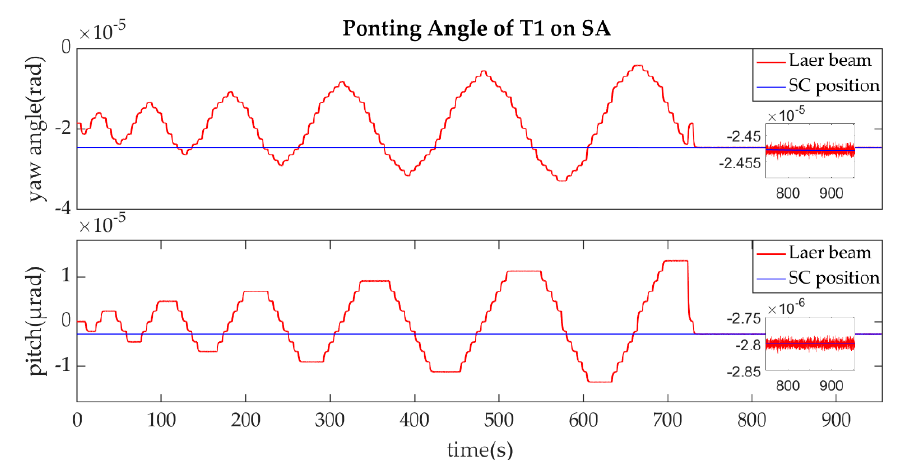
Figure 11. Pointing Angle of T1 on SA.